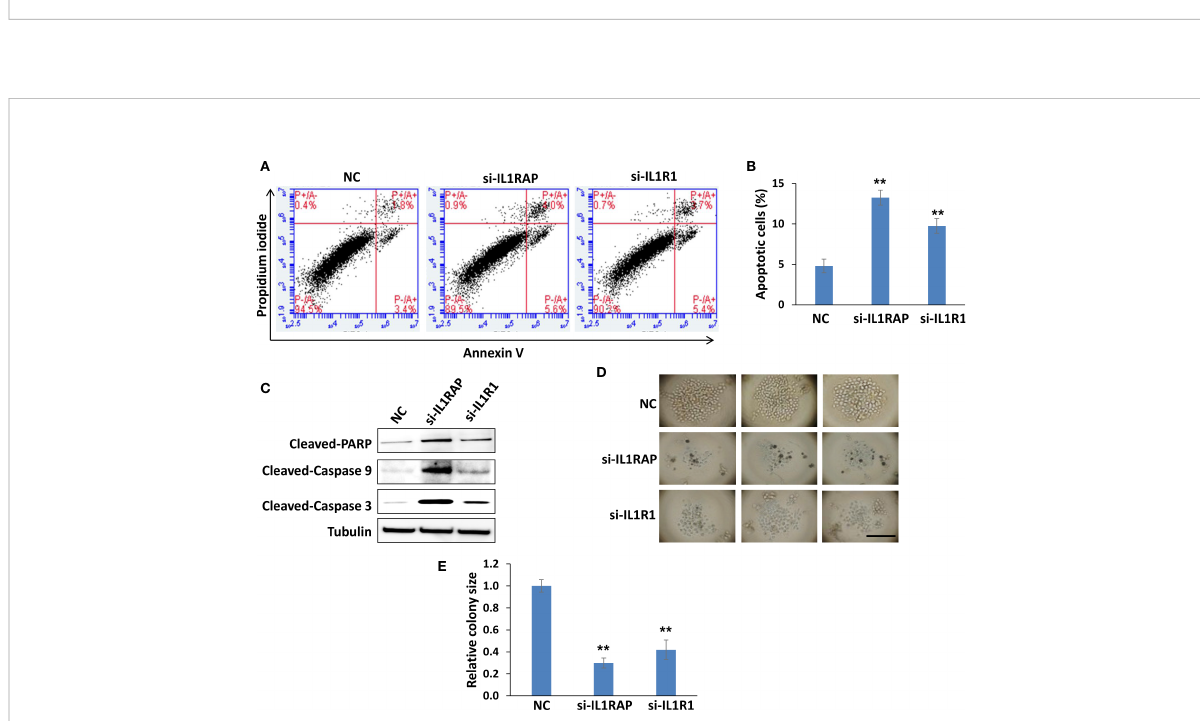
FIGURE 4 Targeting IL1RAP and IL1R1 by RNAi induces PEL cell apoptosis and impairs PEL colony formation. (A, B) BCBL-1 were transfected with 50 nM of IL1RAP-siRNA, IL1R1-siRNA or non-target control siRNA (NC) (Dharmacon SMARTpool siRNA) for 48 h, then the cell apoptosis was quanti fi ed using fl ow cytometry analysis. Error bars represent S.D. for 3 independent experiments, ** = p<0.01. (C) The protein expression was measured using Western blot, and representative blots from one of two independent experiments were shown. (D, E) BCBL-1 were transfected as described above, then seeded into the Coring Elplasia 96-well round bottom microplate featuring Ultra-Low Attachment (ULA) surface. After 72 h culture, the colony formation was detected and measured using a microscope. Error bars represent S.D. for 6 wells from each group, **p<0.01. Bar: 100 m